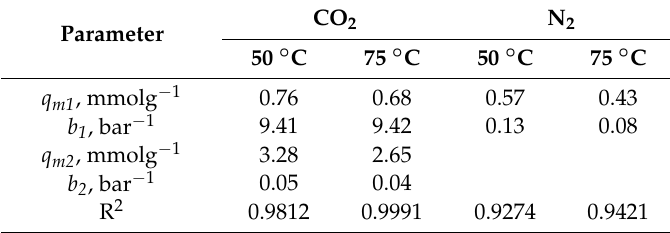
Table 4. Fitting parameters to the experimental data for MSG20 at 50 ◦ C and 75 ◦ C.